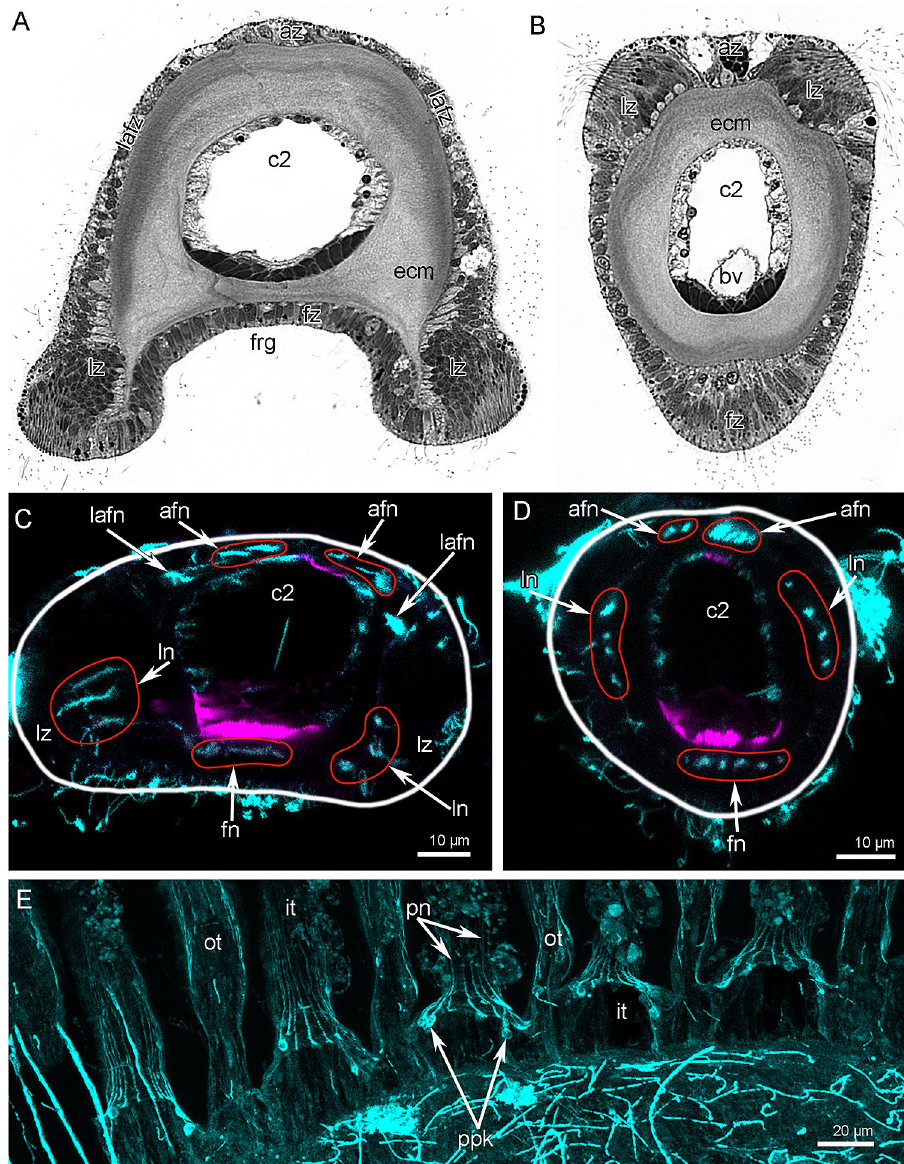
Figure 4. Organization of tentacles in Coptothyris grayi . Semi-thin transverse sections ( A , B ); Z-projections after immunostaining against acetylated alpha-tubulin (cyan) and staining with phalloidin (magenta) ( C – E ). Red circles indicate certain tentacle nerves, which consist of several neurite bundles. ( A ) Outer tentacle. ( B ) Inner tentacle. ( C ) Z-projection of outer tentacle; the border of tentacle is shown by white line. ( D ) Z-projection of inner tentacle; the border of tentacle is shown by white line. ( E ) Z-projection peritoneal neurites in outer and inner tentacles. Abbreviations: afn—abfrontal tentacle nerve; az—abfrontal zone; bv—tentacle blood vessel; c2— tentacle coelom (mesocoel); ecm—extracellular matrix; fz—frontal zone; fn—frontal tentacle nerve; frg—frontal groove; it—inner tentacle; lafn—lateroabfrontal tentacle nerve; lafz—lateroabfrontal zone; ln—lateral tentacle nerve; lz—lateral zone; pn—peritoneal neurite; ot—outer tentacle; ppk—peritoneal